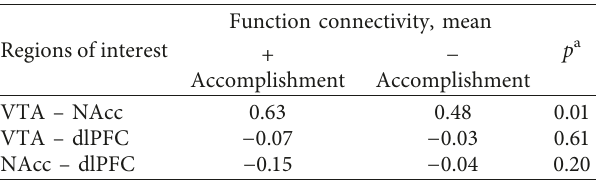
Table 6: Resting-state functional connectivity of meso- corticolimbic regions in a reward network, among participants with and without “Happy task” responses in the accomplishment do- main ( n �